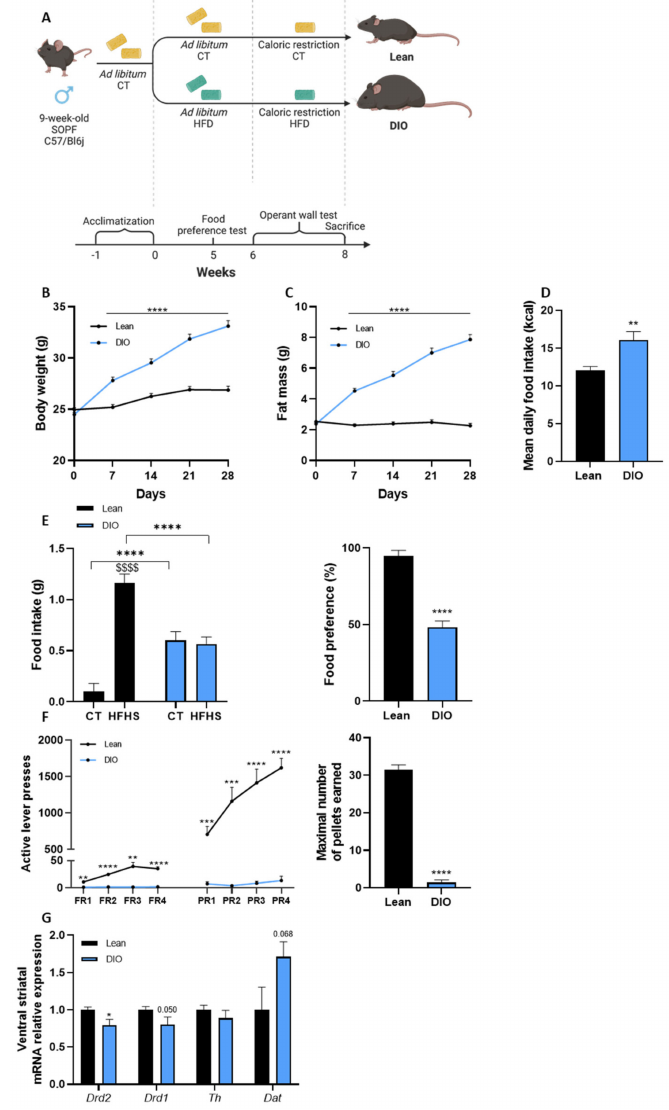
Figure 1. Obesity is associated with an increased body weight, fat mass and calories intake with an alteration of the food reward system. Mice were monitored during 8 weeks of a HFD or a CT. ( A ) Experimental plan of the experiment 1. Created with BioRender.com. ( B ) Body weight evolution and ( C ) fat mass evolution over 4 weeks. ( D ) Mean daily food intake in kcal. ( E ) Food preference test showing HFHS and CT intake in grams and preference for HFHS in percentage after 3 h of test by lean and DIO mice. The percentage of food preference was calculated based on HFHS intake (g) during the food preference test divided by the total food intake (g) eaten during the food preference test. ( F ) Operant conditioning test showing the number of active lever presses during the four progressive ratio (PR) sessions and the maximal number of pellets earned during the PR4 by lean and DIO mice. ( G ) Ventral striatal mRNA relative expression of dopamine receptor 2 ( Drd2 ), dopamine receptor 1 ( Drd1 ), tyrosine hydroxylase ( Th ) and dopamine transporter ( Dat ) measured by real-time qPCR in lean and DIO mice. Data are shown as mean ± SEM. p -values were obtained after two-way ANOVA repeated measure followed by Bonferroni post-hoc test. ( n = 20/group). ( B , C ) after unpaired Student’s t -test ( n = 20/group) ( D ) after two-way ANOVA followed by Bonferroni post-hoc test. ( n = 10–12/group) ( E ) after two-way ANOVA followed by Bonferroni post-hoc test ( n = 12/group) ( F ) after unpaired Student’s t -test or non-parametric Mann-Whitney test ( n = 9–12/group) ( E , F , G ) *: p -value < 0.05; **: p -value < 0.01; ***: p -value < 0.001; ****: p -value < 0.0001 between lean vs. DIO. $$$$: p -value < 0.0001 between CT vs. HFHS food